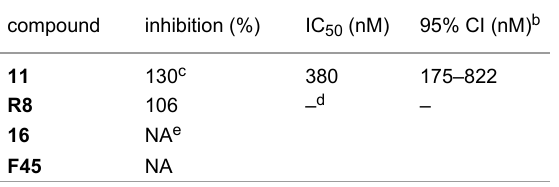
Table 4: SdiA antagonism assay data for select compounds in the E. coli reporter.